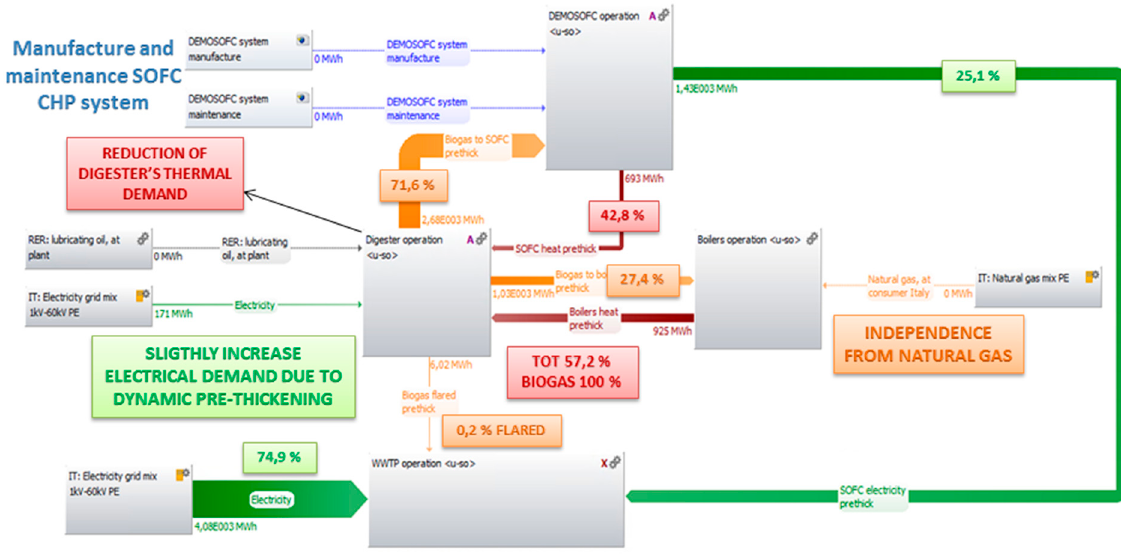
Figure A3. Energetic flows in Scenario Figure A3 . Energetic flows in Scenario 3.